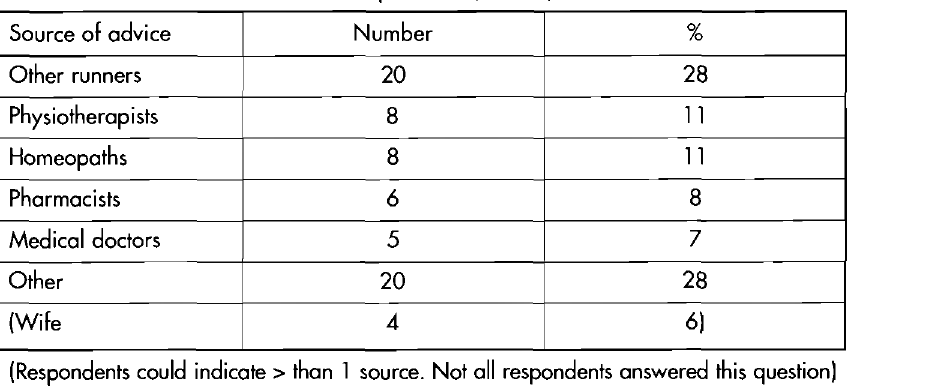
Table 3: The source from whom the respondents (n = 72) heard about Arnica.